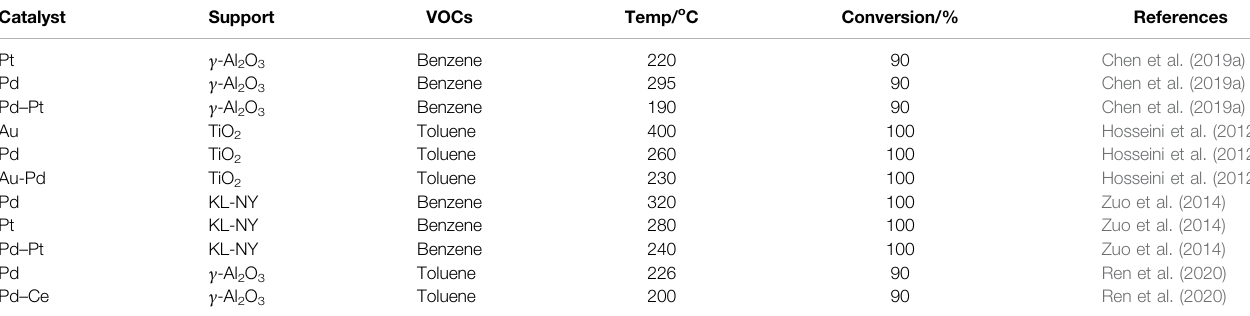
TABLE 3 | Reported alloyed nanoparticles catalysts for volatile organic compounds (VOCs) catalytic oxidation.